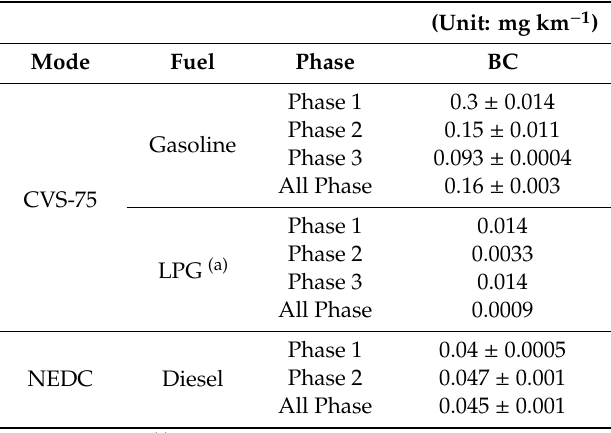
Table 3. The results of BC emissions in CVS-75 mode for GDI gasoline and LPG vehicles, NEDC mode for diesel vehicle corresponding to emission certification mode in Korea.